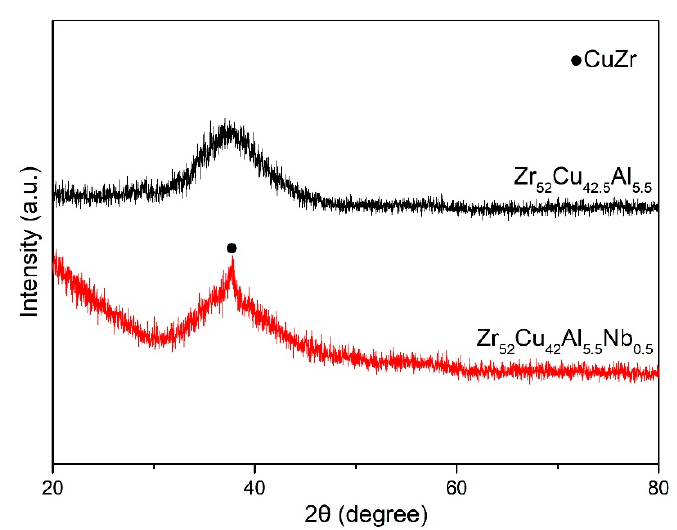
Figure 1. The XRD pattern of Zr 52 Cu 42.5-x Al 5.5 Nb x (x = 0 and 0.5 atom%).